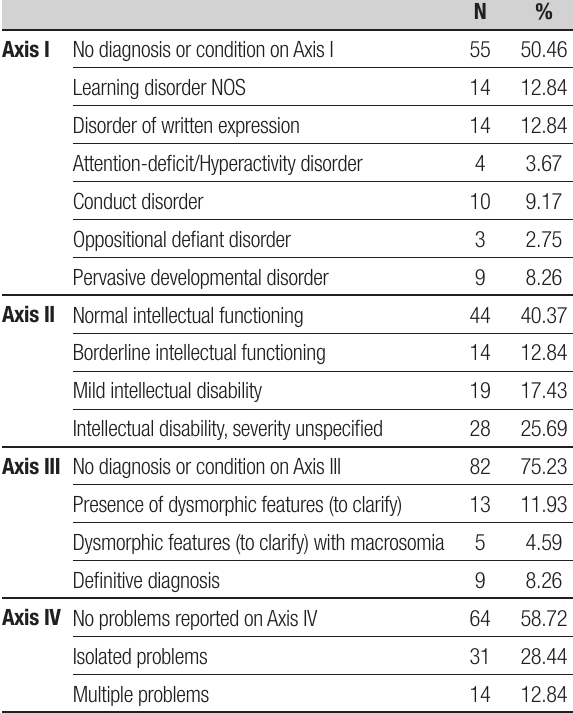
Table 2. Distribution of diagnoses according to DSM-IV